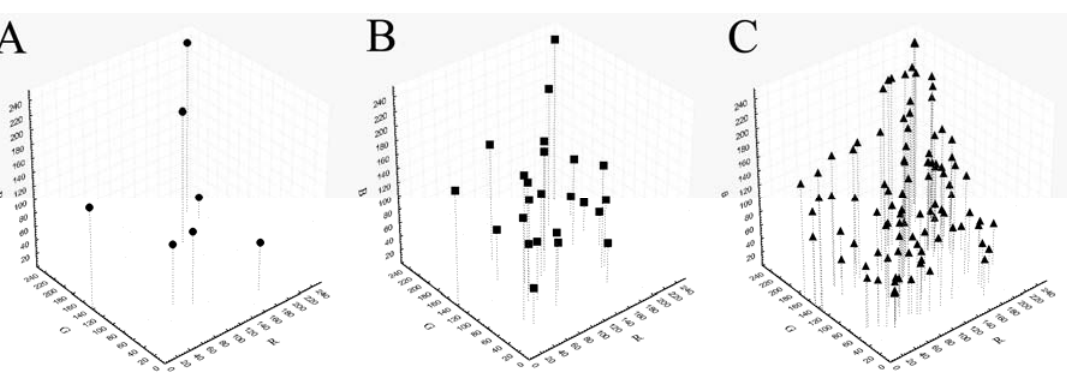
Figure 1. sRGB values of the patches of each ColorChecker in the sRGB